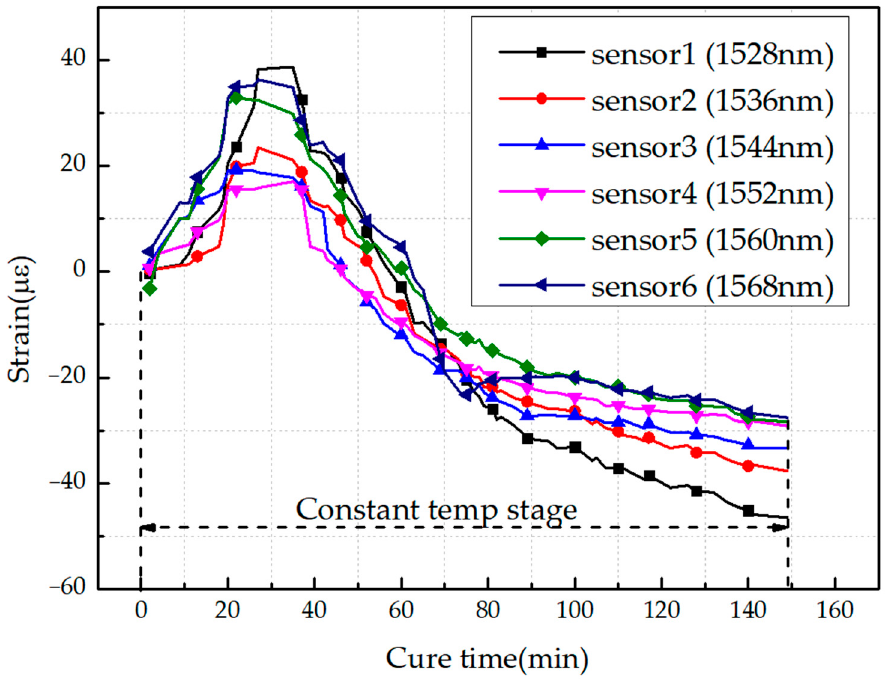
Figure 12. Strain of FBG sensors with different wavelengths during the constant temperature stage.